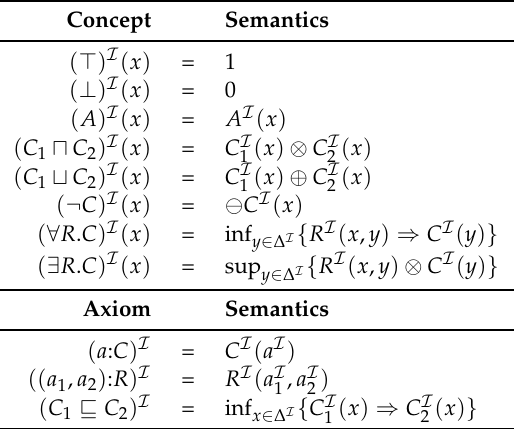
Table 2. Semantics of fuzzy concepts and axioms